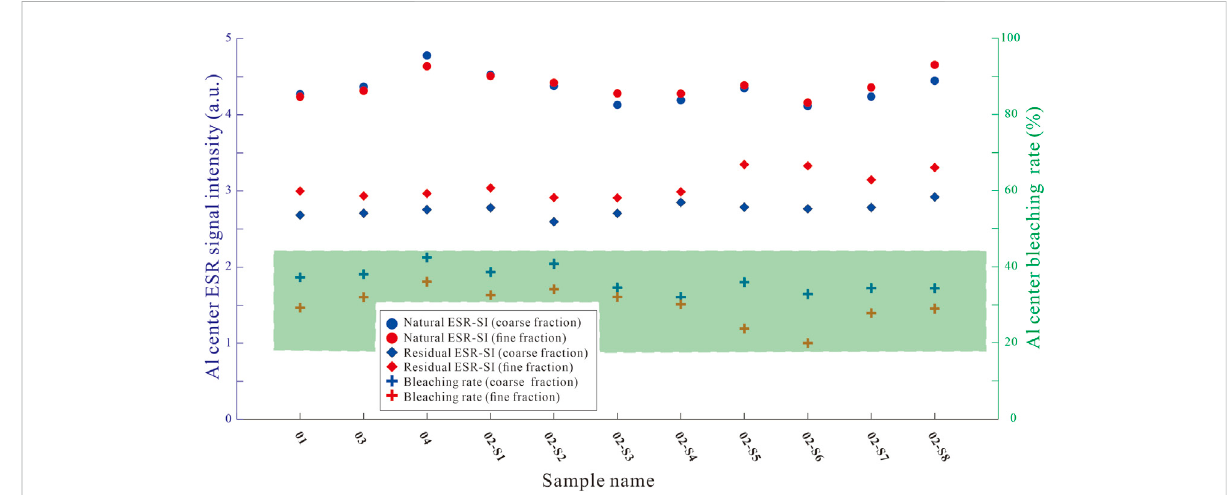
FIGURE 9 Comparison of natural and residual quartz Al center ESR signal intensity (ESR-SI).